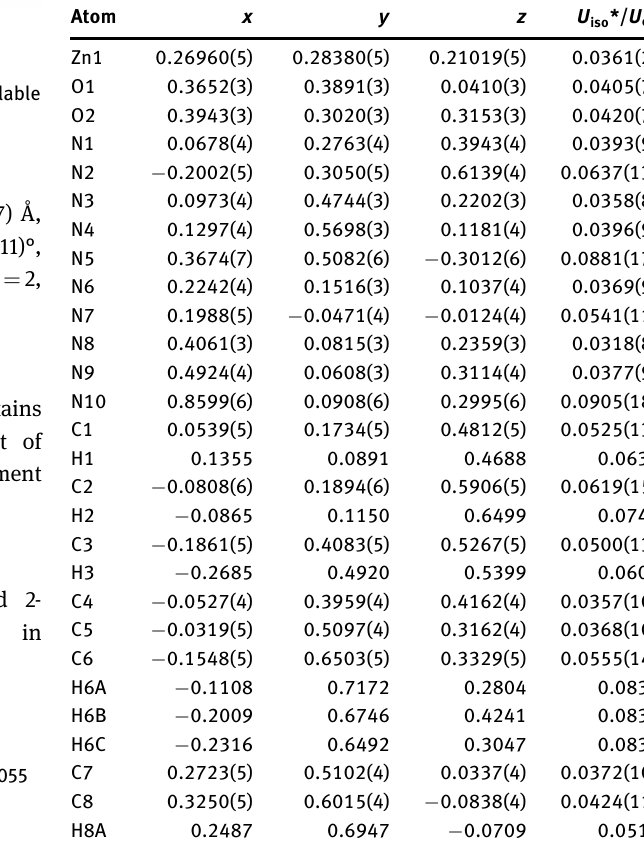
Table 2: Fractional atomic coordinates and isotropic or equivalent isotropic displacement parameters (Å 2